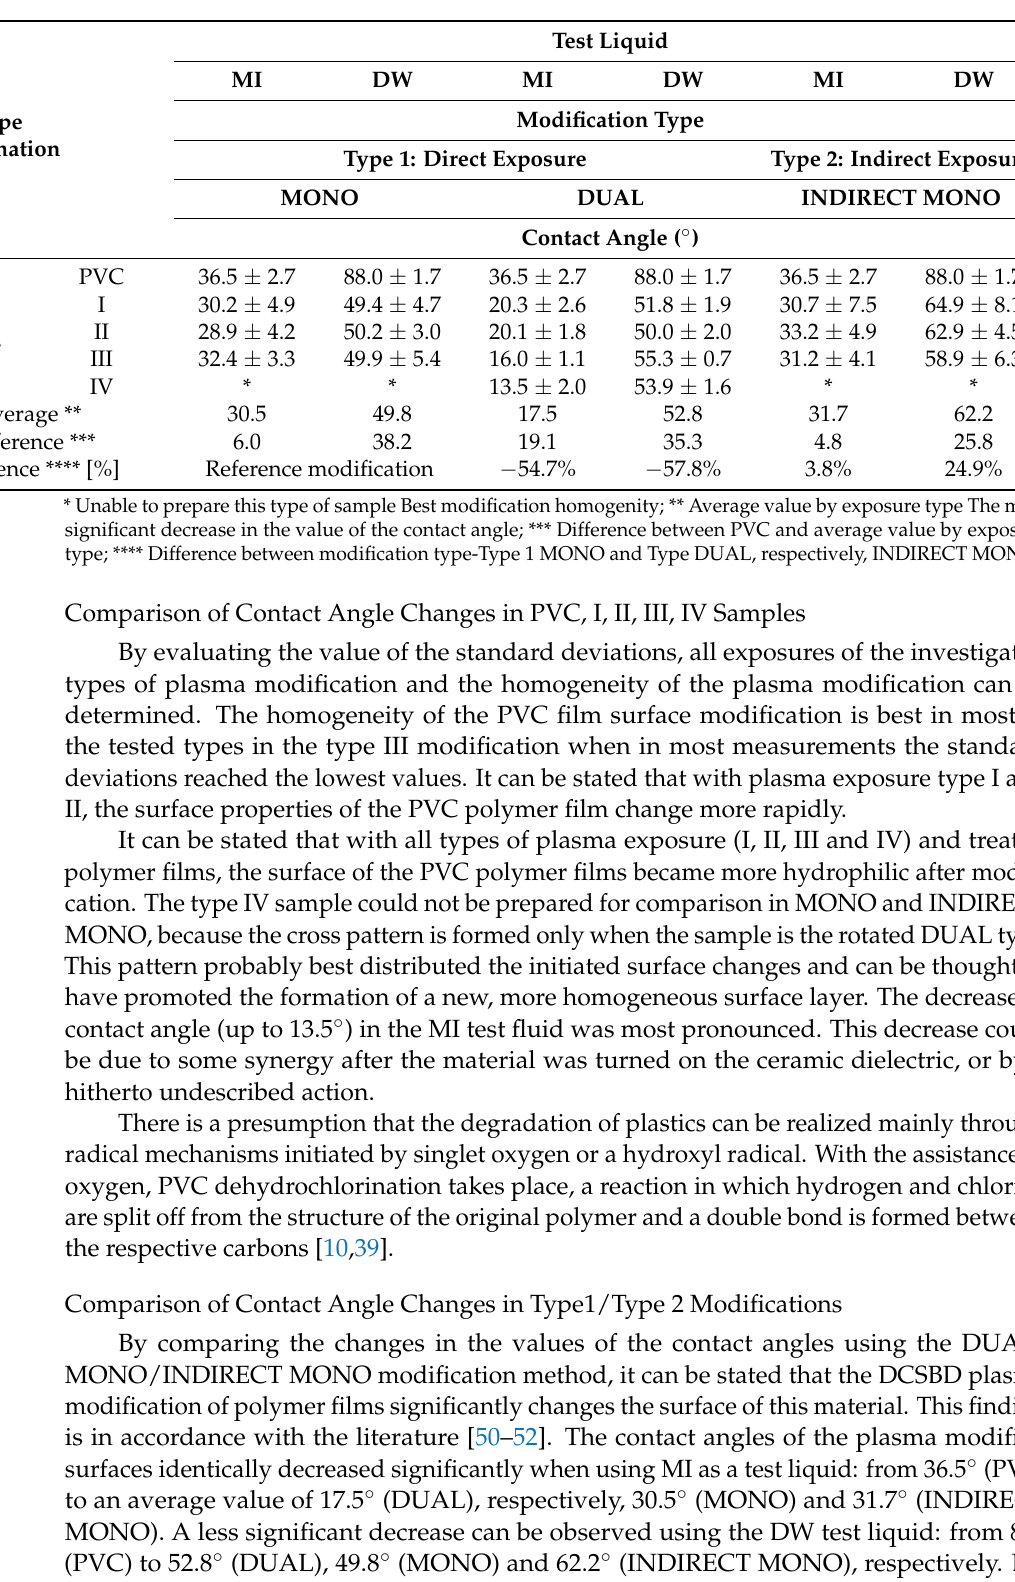
Table 1. Contact angle values of samples using the DUAL, MONO, and INDIRECT MONO